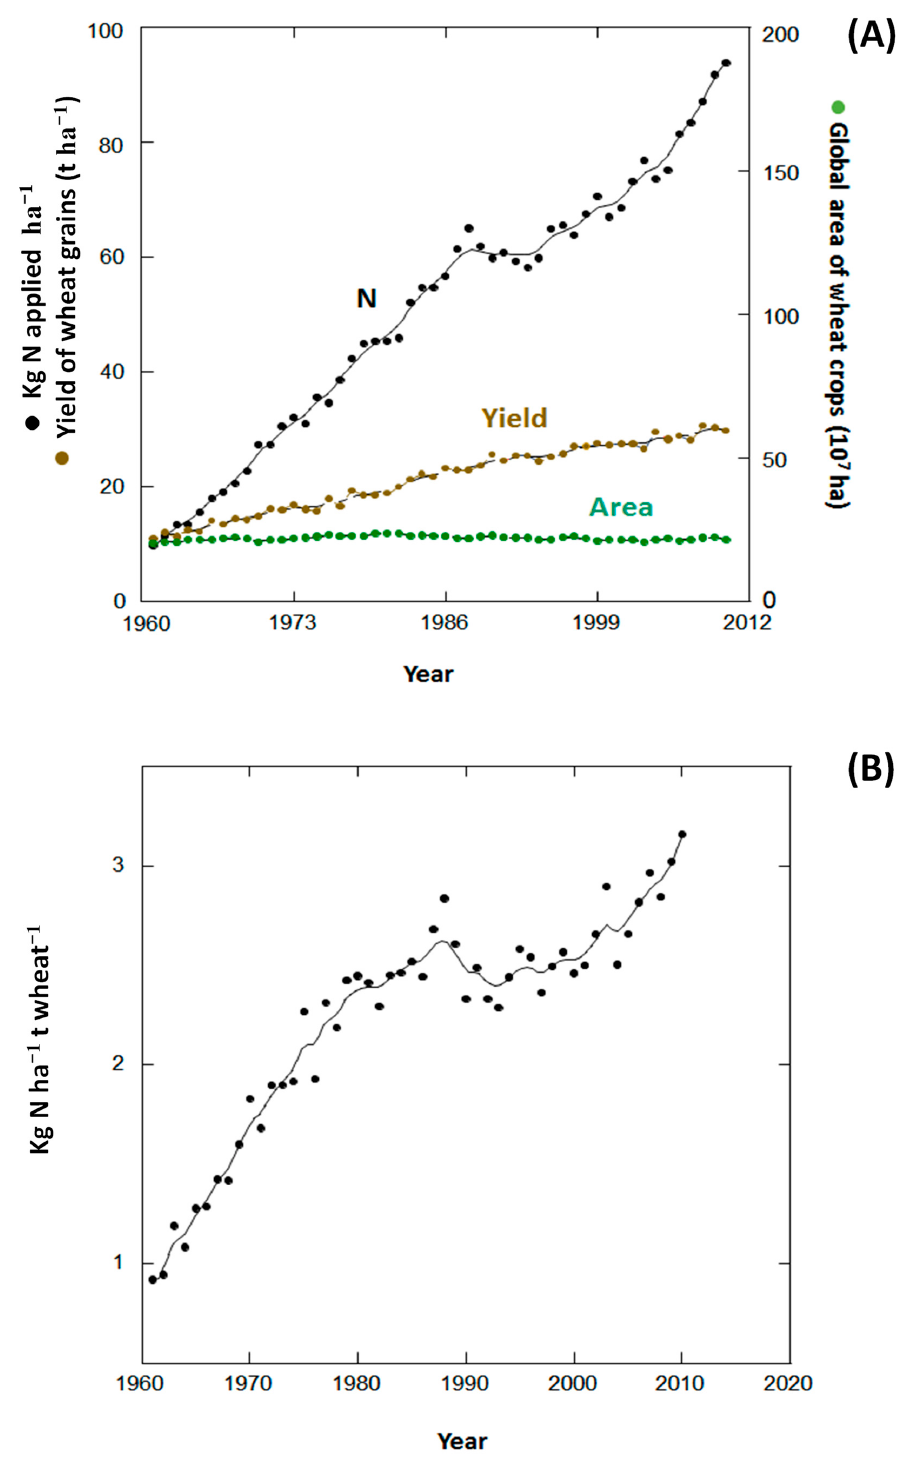
Figure 1. Global N-fertilisation rates (kg N ha − 1 y − 1 ) in wheat crops. Wheat grain yield (t ha − 1 y − 1 ) and global annual area of wheat crops (10 7 ha) during 1961–2016 (1961–2010 for N-fertilisation rates) ( A ).